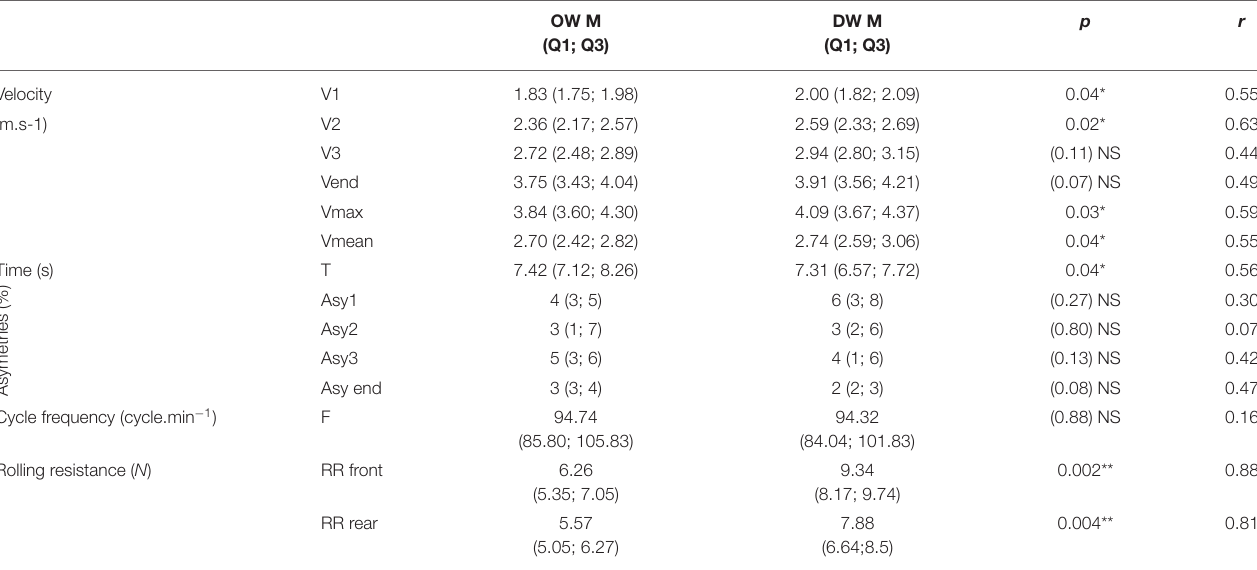
TABLE 3 | M (median), Q1 (first quartile) and Q3 (third quartile) of velocities (m.s − 1 ); time (s); asymmetry (%): relative difference in velocity between the left and right side; F (cycle.min − 1 ): Cycle Frequency and RR (N): rolling resistance.